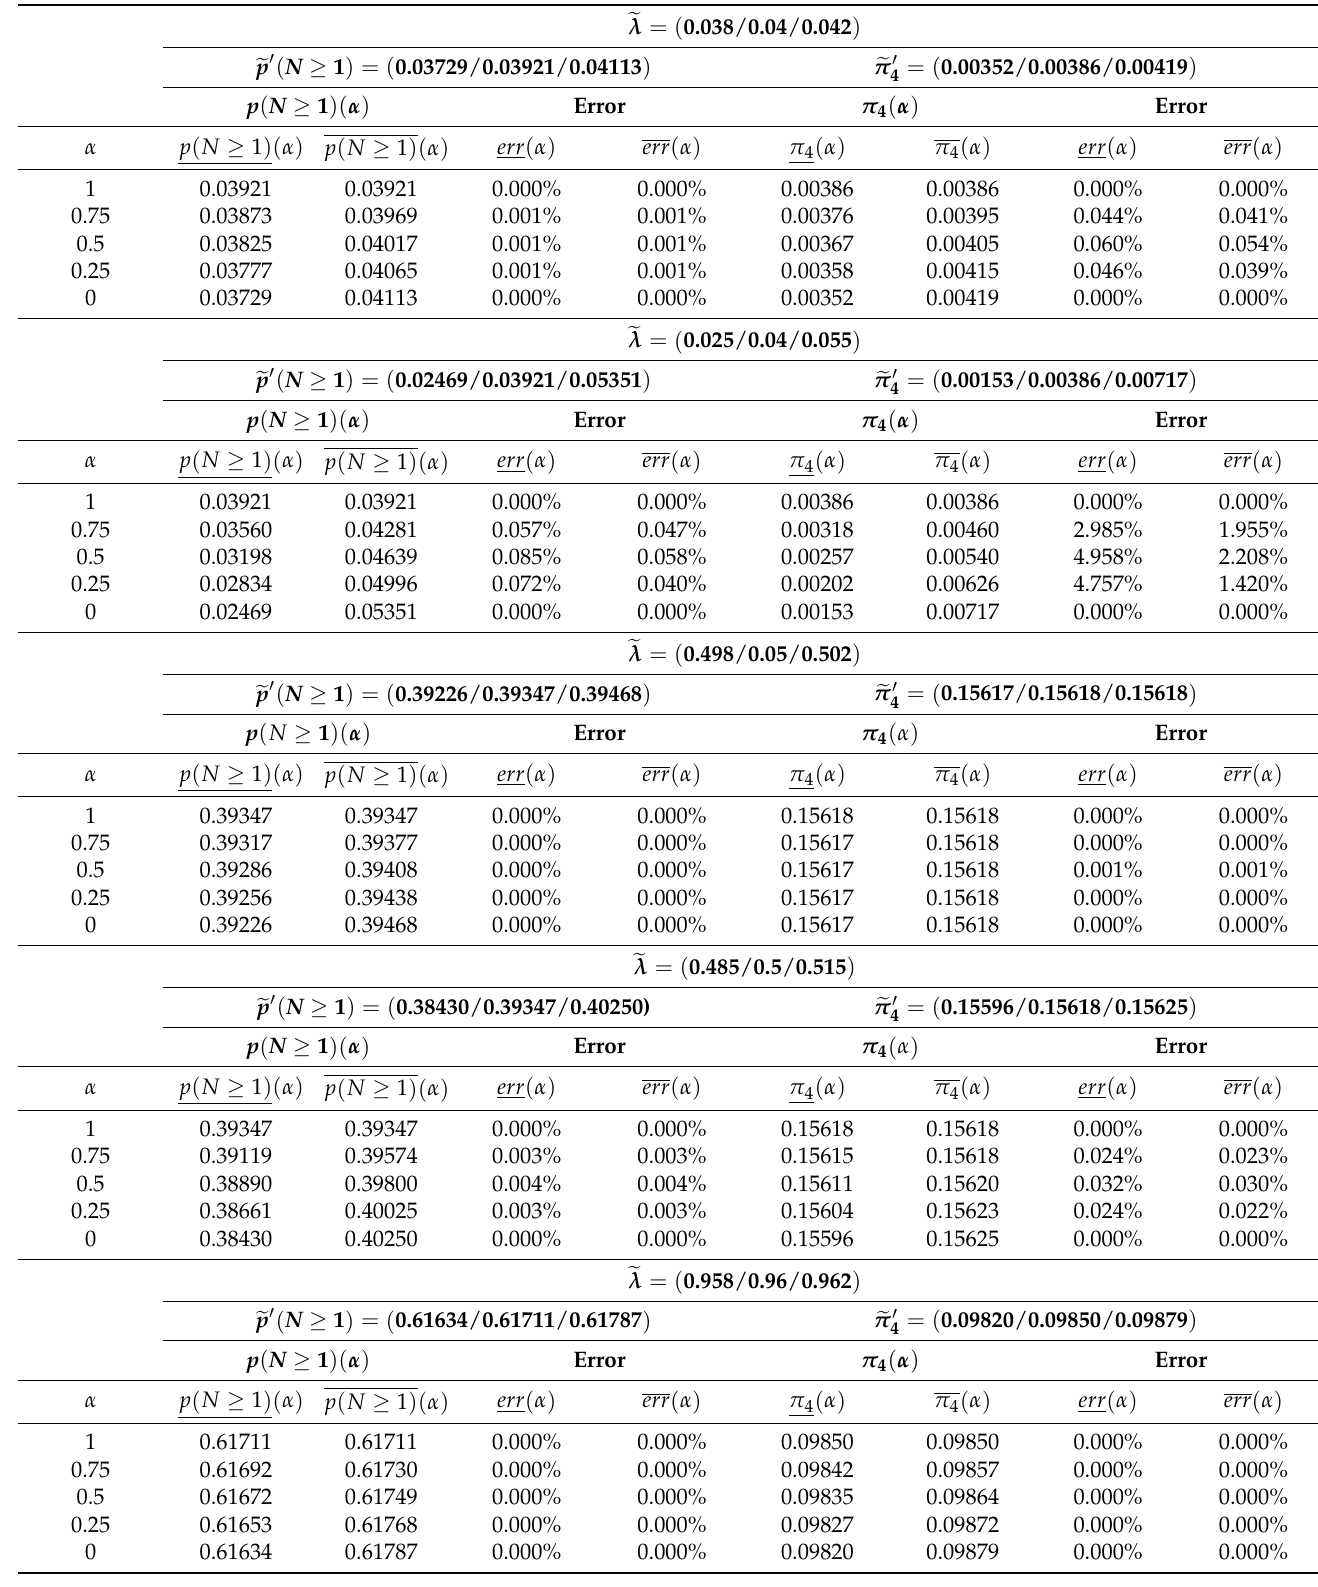
Table 7. α -cuts of (cid:101) p ( N ≥ 1 ) and (cid:101) π 4 , their triangular approximate and errors for different parameters (cid:101) λ